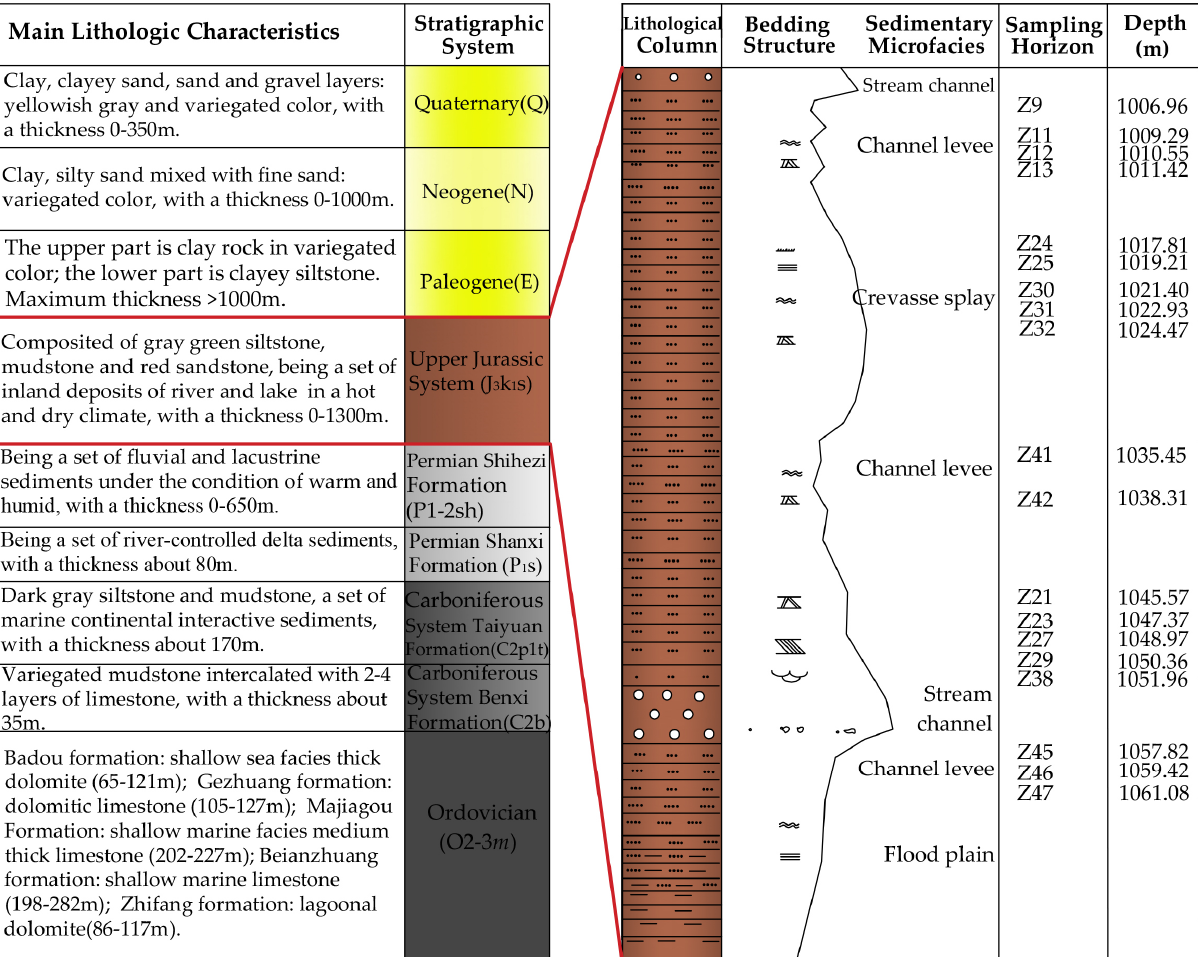
Figure 1. The sampling horizons and depths of the Jurassic sandstone collected from the Anju coal mine of the Southwest Shandong coalfield: The colored column on the left shows the overall strat- igraphic structure of the Southwest Shandong coalfield; The orange column on the right shows the stratigraphic texture of the Jurassic System (J 3 k 1 s) in detail.